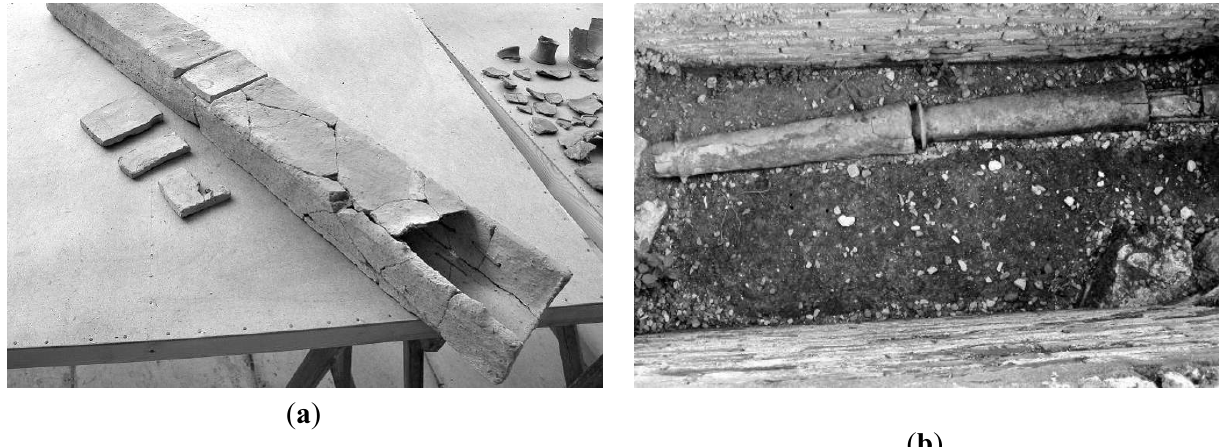
Figure 1. Minoan water distribution projects: pipes of rectangular shape from Myrtos-Pyrgos ( a ) and closed terracotta pipes at Knossos palace ( b